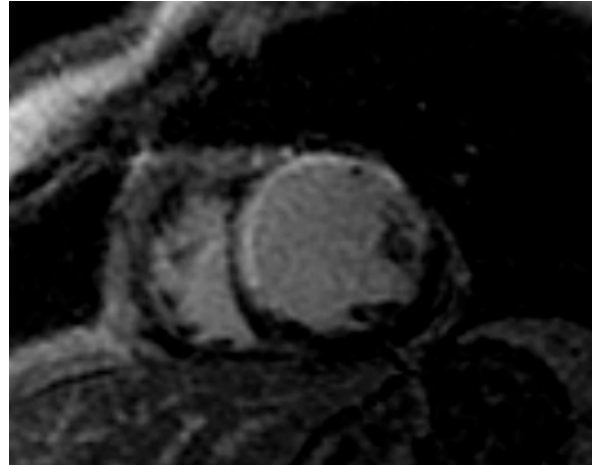
Figure 2. Myocardial infarction (white area) in an obese adult. Table 1. Comparison of noninvasive imaging modalities in the evaluation of obese subjects